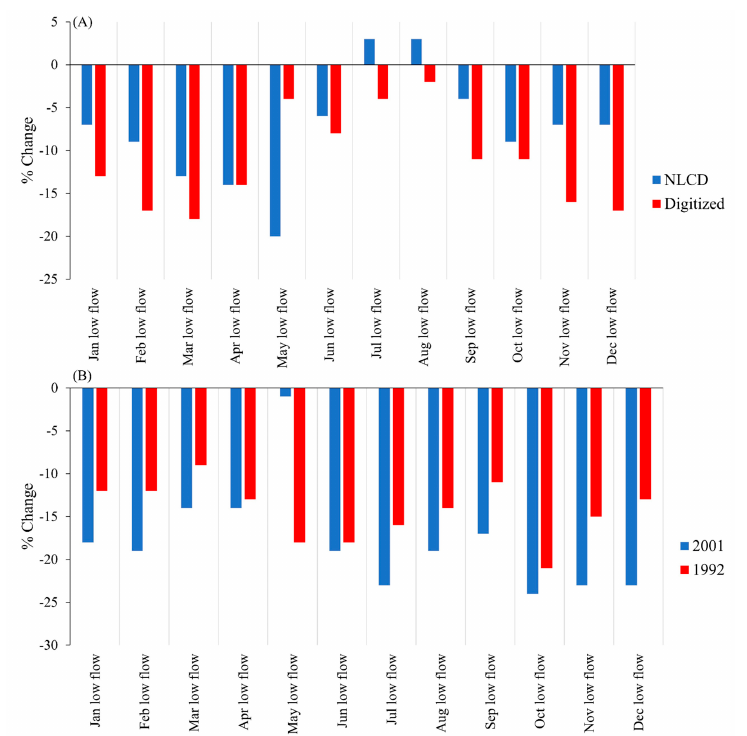
Figure 9. Changes in monthly low flows. Percent differences in the magnitude of monthly low flows due to the source of LULC data ( A ) and due to the temporal condition of LULC distribution in the watershed using 1992 and 2011 LULC data ( B ).